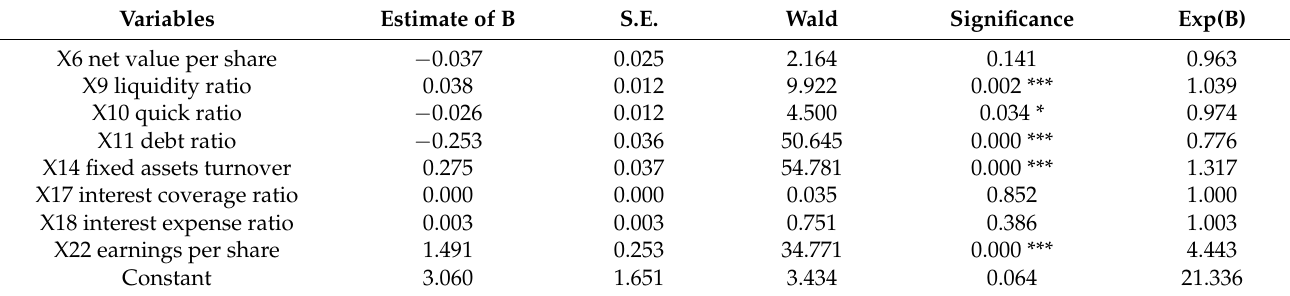
Table 18. Significance values of feature selection variables of 1964 normal and 491 bankrupt companies (4:1) in LR.